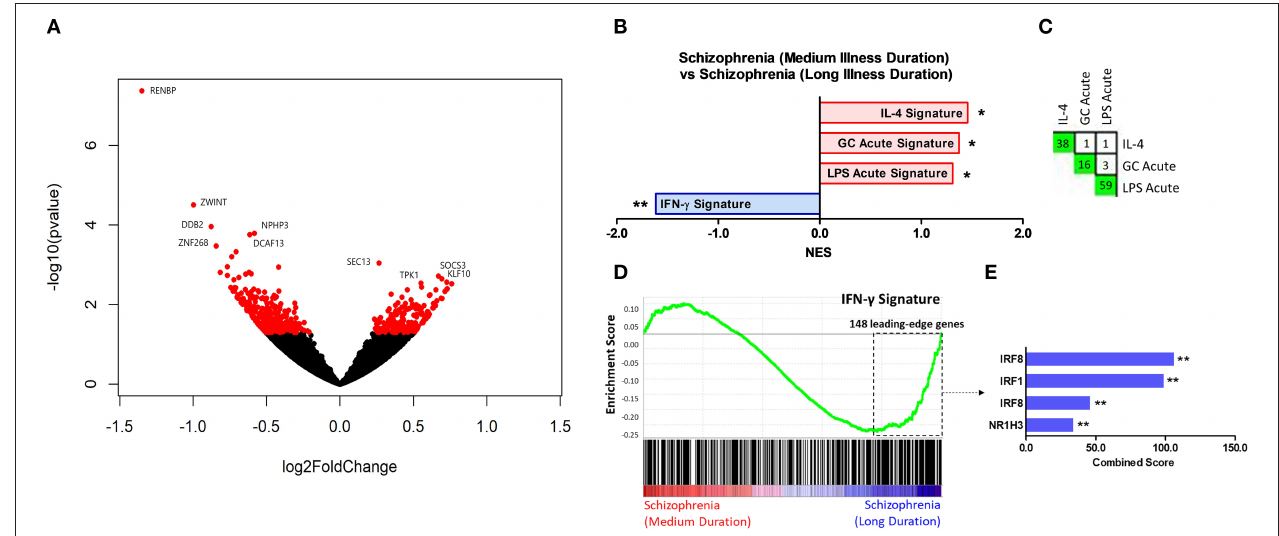
FIGURE 5 | (A) Volcano plot of DGE: medium vs. long illness duration participants. p < 0.05 labeled red. (B) Signatures that were enriched in the medium illness duration group compared to the long illness duration group. **FDR < 0.05, *FDR < 0.25. (C) Leading-edge analysis for signatures enriched amongst genes increased in the medium illness duration group compared to controls. The number and green gradient indicate overlapping leading-edge subset genes between the corresponding signatures. (D) Enrichment plot for the IFN- γ signature in the long illness duration group compared to controls. Genes are ranked from greatest increase to the greatest decrease in expression in the long illness duration group compared to controls. Black lines indicate the location of genes that are in both the ranked list and gene set . (E) Top three results from the TFEA of the leading-edge subset genes in the IFN- γ signature. ** p < 0.001 and adjusted p <